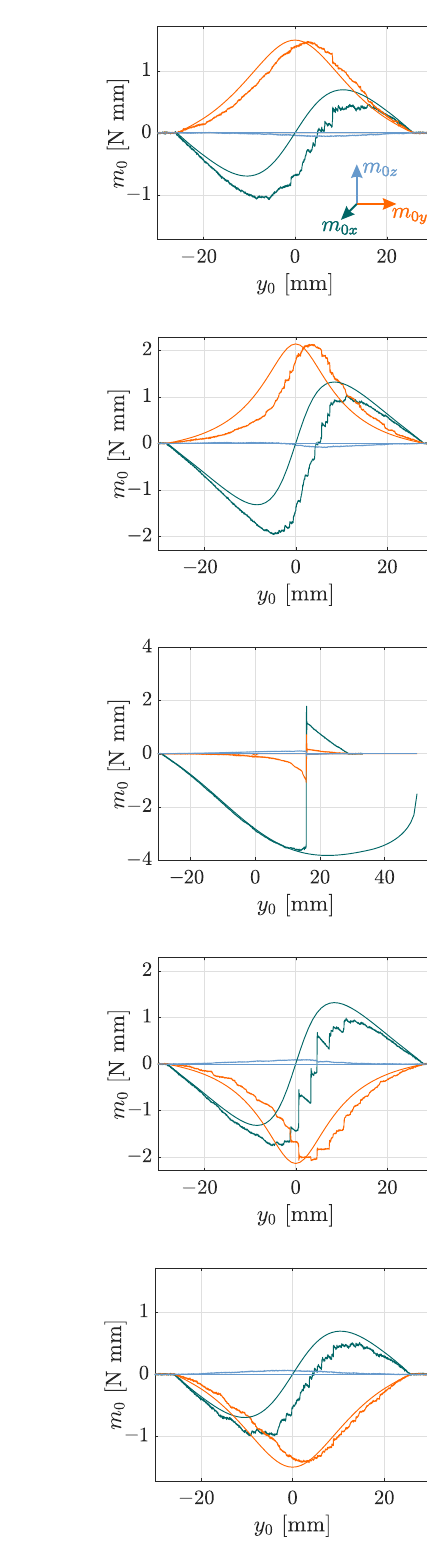
Figure 9. Simulated and measured observables, represented by smooth and noisy data, respectively, during object scanning of a 60 mm glass sphere. Each row results from object scanning according to the scanning sweeps ( A – E ), schematically shown in Figure 7, and includes the following diagrams: reaction forces on the left and reaction moments on the